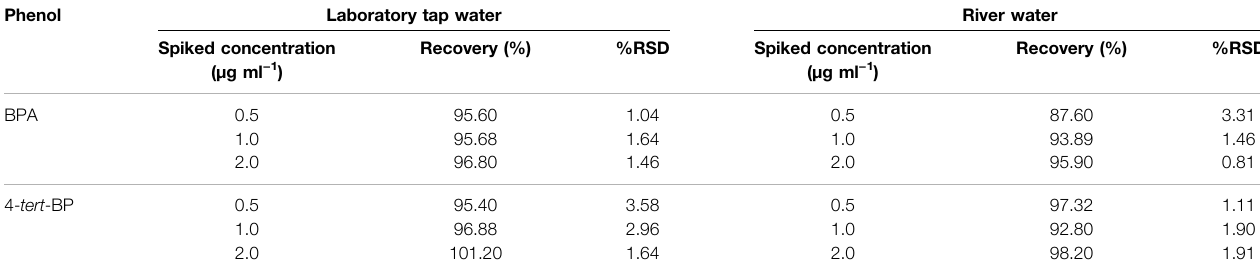
TABLE 4 | Mean recovery and precision of the two analytes in water samples. Phenol